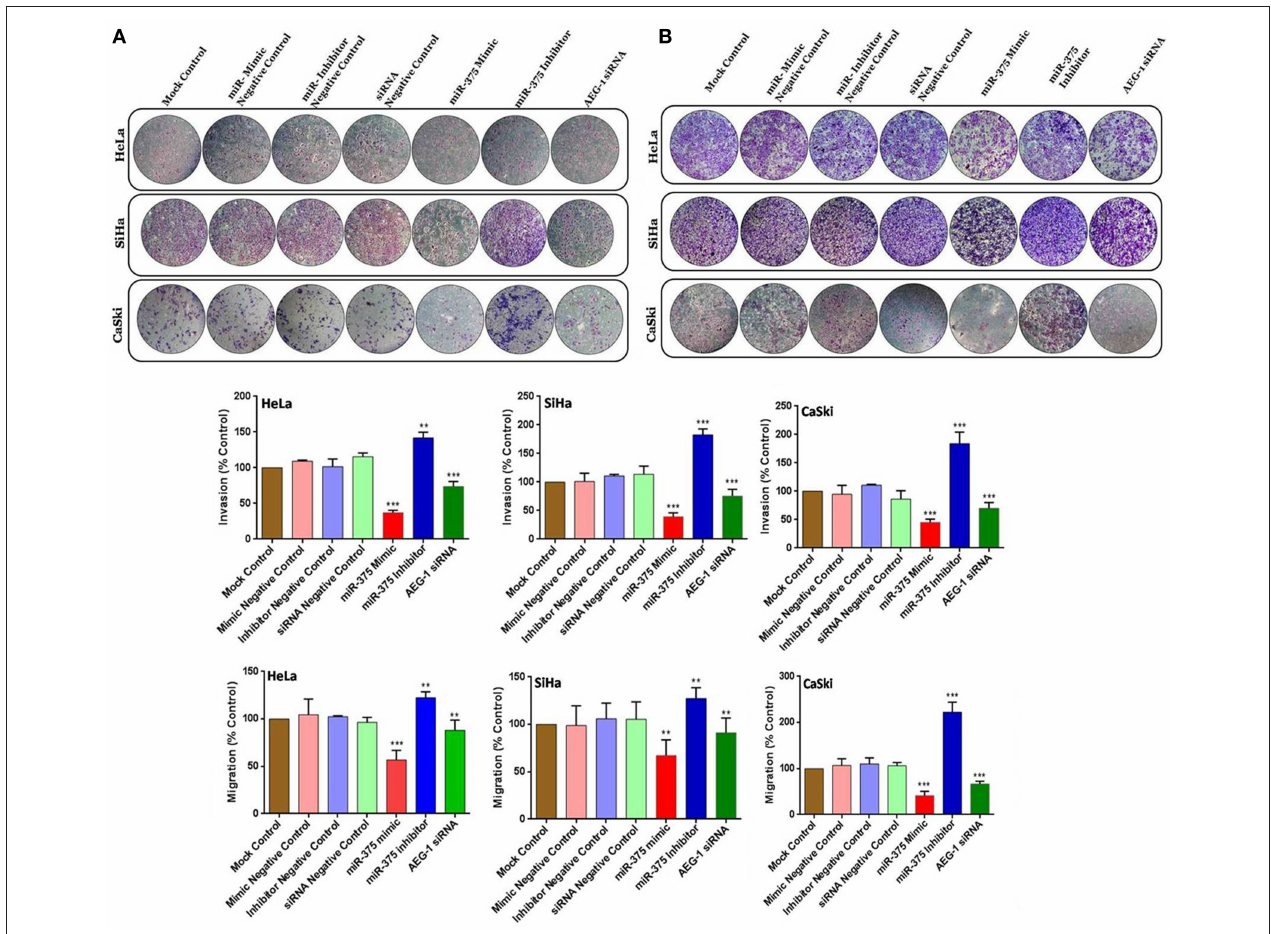
FIGURE 4 | miR-375 suppressed the invasion and migration in cervical cancer cells. Transwell invasion assay with Matrigel was performed in miR-375 mimic, miR-375 Inhibitor, AEG-1 siRNA and their controls transfected CC cells (A) . Transwell migration assay without Matrigel was performed in miR-375 mimic, miR-375 Inhibitor, AEG-1 siRNA, and their controls transfected CC cells (B) . The scale bars represent 100 µ m. Error bars represent mean ± s.d. and P- values are represented as ** P < 0.05, *** P < 0.001 compared to the corresponding